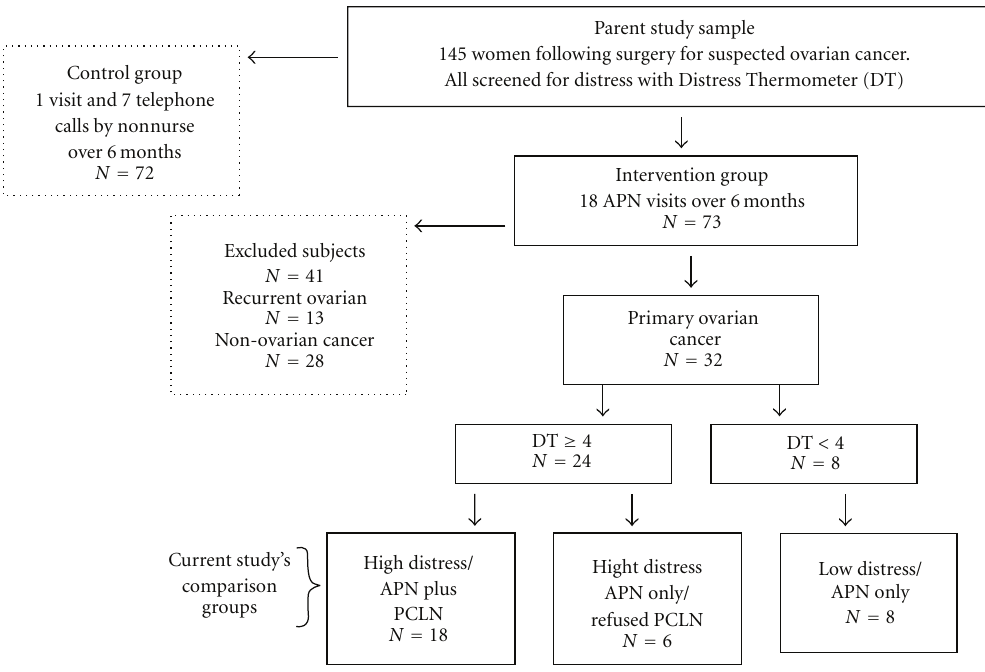
Figure 2: Schematic representation of study’s sampling